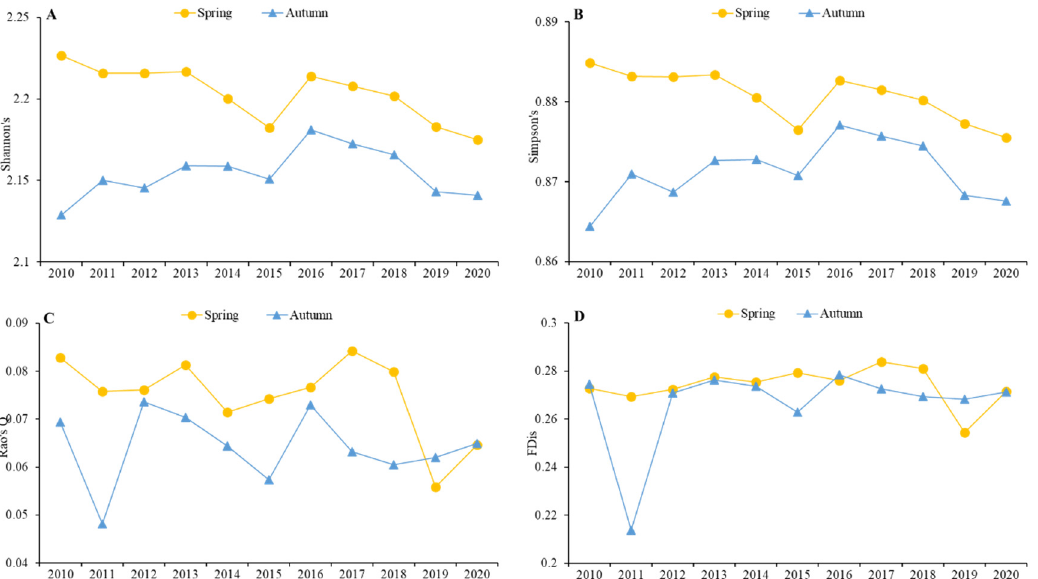
Figure 4. Annual and seasonal trends of alpha functional diversity indexes, ( A ) Shannon’s, ( B ) Simpson’s, ( C ) Rao’s Q, and ( D ) Functional dispersion (FDis).